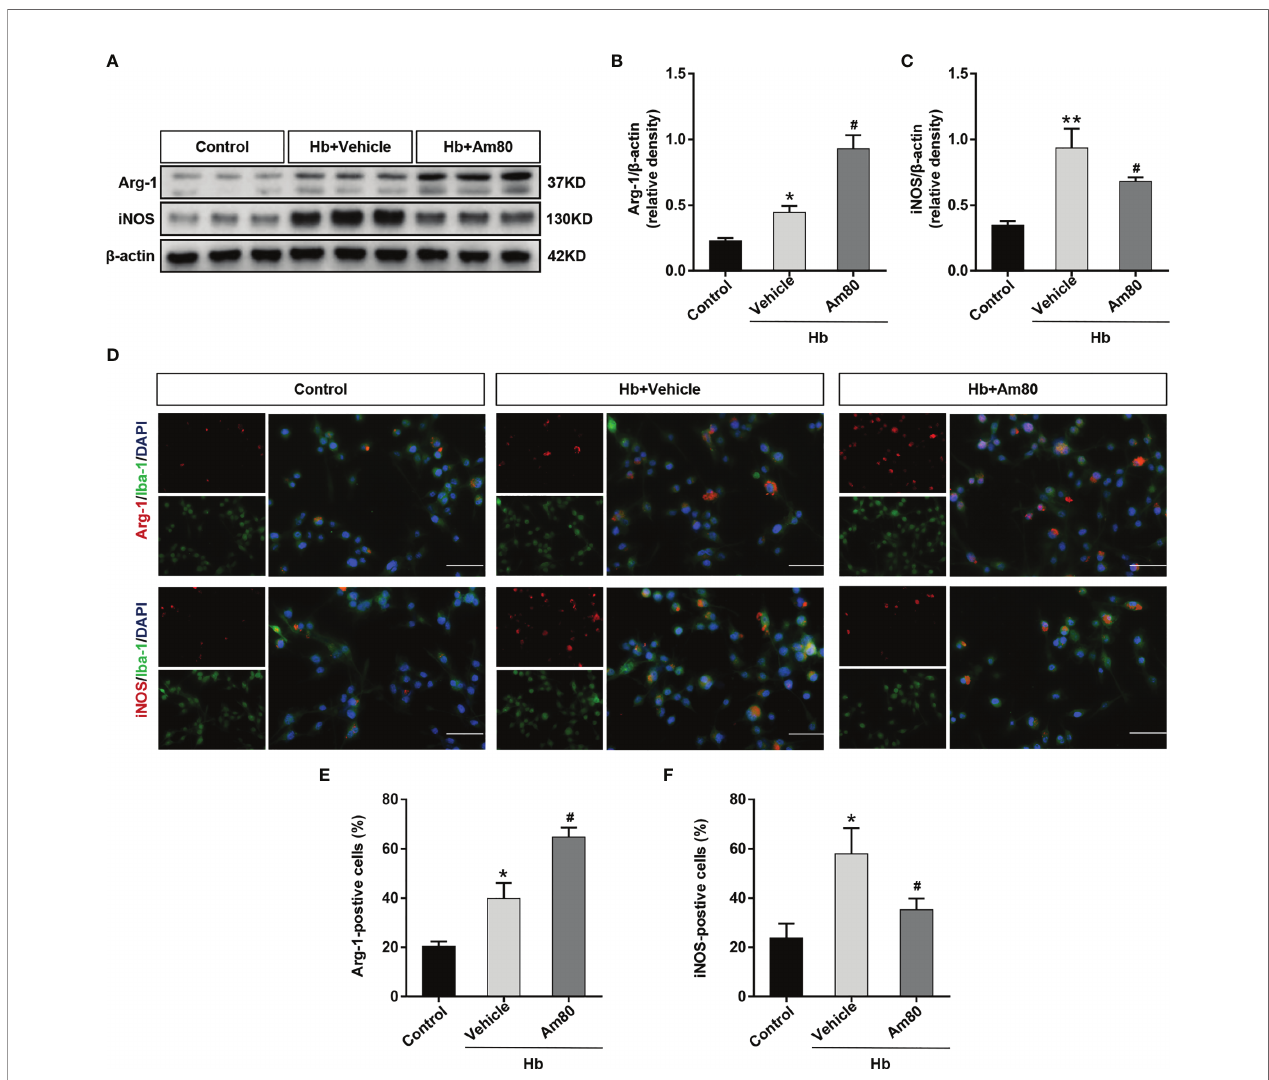
FIGURE 6 | Am80 promoted M1-to-M2 phenotypic polarization of microglia in an in vitro model of SAH. (A – C) Western blotting and quantitative analyses Arg-1 and iNOS expression of microglia in an in vitro co-culture system. n=3 per group. (D – F) Immuno fl uorescence staining of Arg-1/iNOS and microglia in an in vitro co-culture system and quantitative analyses of Arg-1/iNOS positive cells. Scale bar=50 m m. n = 3 per group. * P < 0.05 vs control group; ** P < 0.01 vs control group; # P < 0.05 vs Hb+vehicle